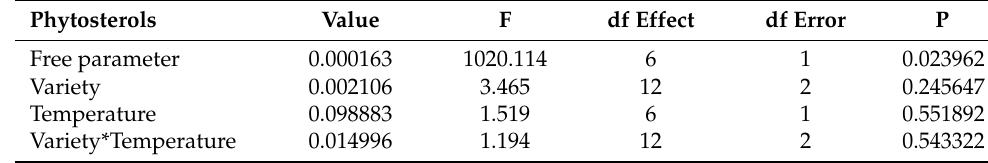
Table 6. The results of the MANOVA multivariate test of phytosterols (method: Wilks test).